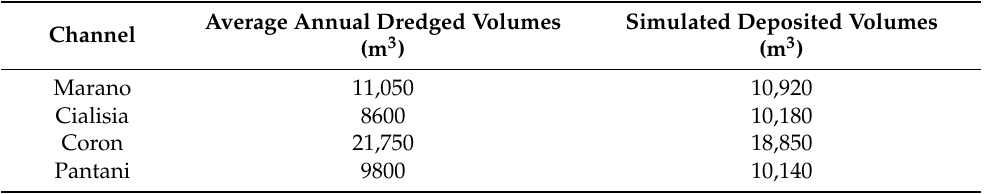
Table 2. Comparison of the simulated deposited volumes of sediments with the average annual dredged